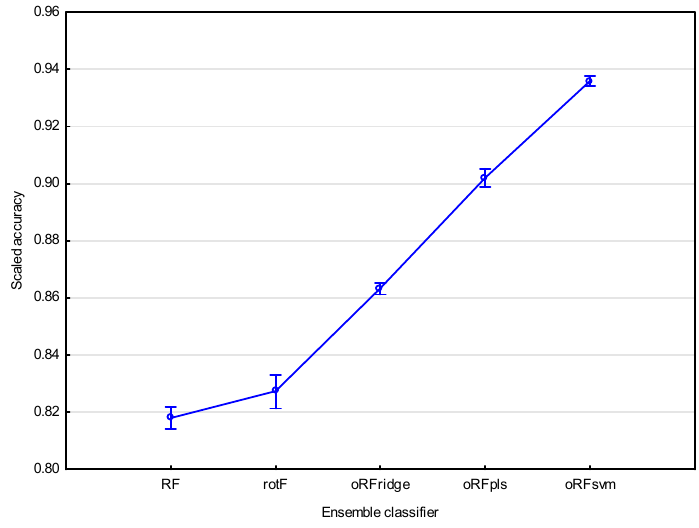
Figure 4. Mean classification accuracies for all tree-based algorithms (RF = random forest; rotF = rotation forest; oRFridge = oblique random forest using ridge regression as splitting model; oRFpls = oblique random forest using PLS as splitting model; oRFsvm = oblique random forest using SVM as splitting model) considered in this study. The scaled accuracy is the classification accuracy represented on a scale ranging from zero to one. Vertical bars denote 0.95 confidence intervals.